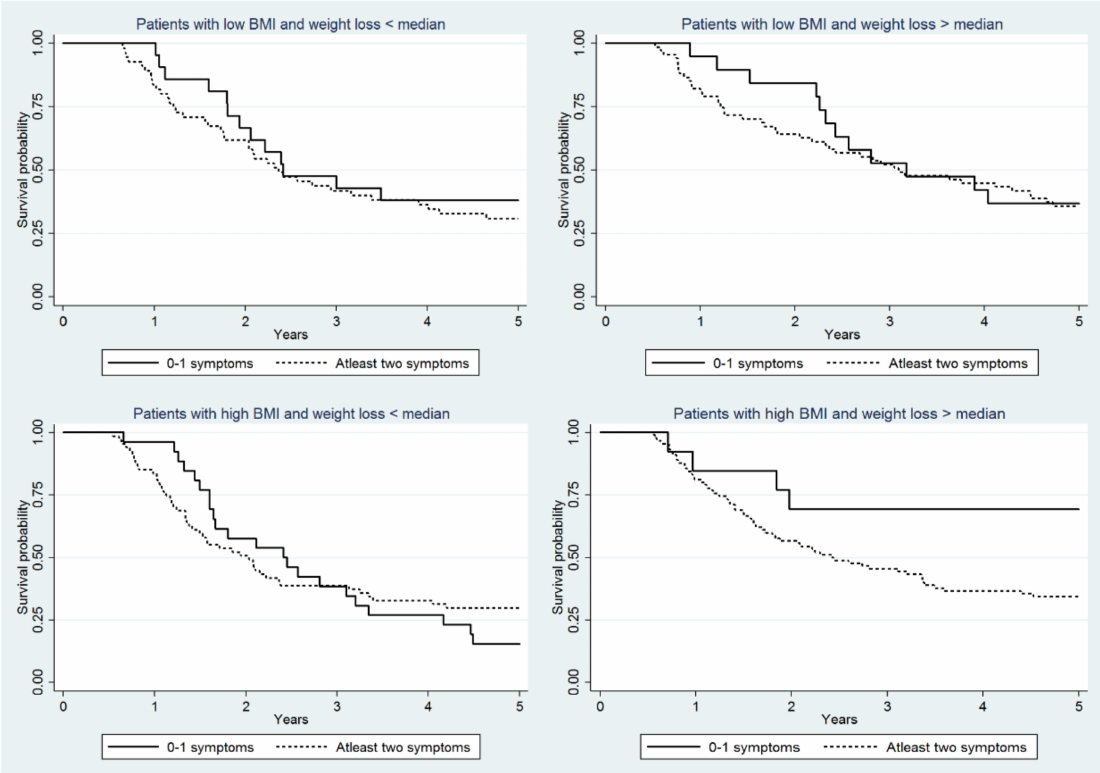
Figure 3. Panel diagrams of Kaplan Meier curves of overall 5-year survival of oesophageal cancer patients with at least 2 symptoms vs patients with 0–1 symptom as reference according to intensity of postoperative WL and preoperative BMI category. BMI—Body mass index; NIS—Nutrition Impact symptoms; WL—weight